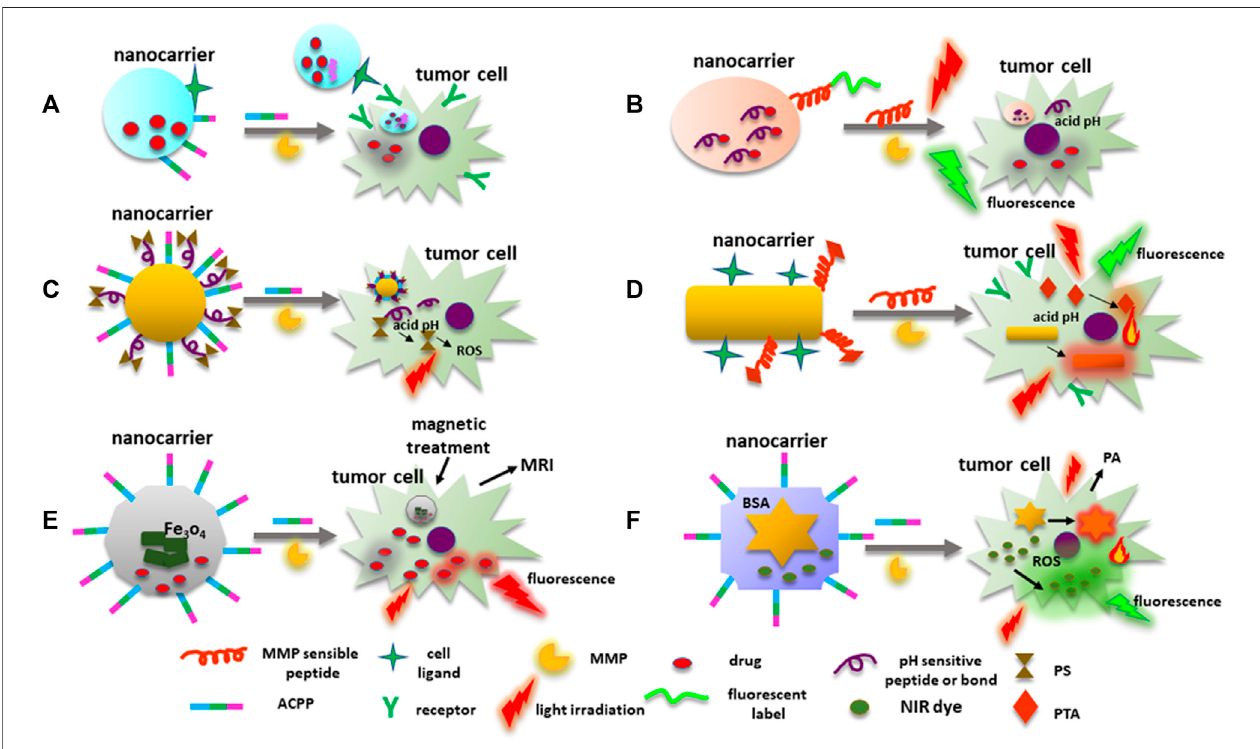
FIGURE6| MMPs ’ cleavablepeptidesinnanocarriers ’ construction. (A) Anexampleofananosystemdesigned fordrugtransportwithligandstotarget neoplastic cells. ACPPs with an MMP sensible peptide, are directly conjugated to NM surface to facilitate nanocarrier cell uptake. (B) Fluorescence label linked to a nanocarrier surface through an MMPs ’ sensible peptide emits fl uorescence when active MMPs disrupt the peptide. Drugs transported by the nanocarrier can be linked to the NP throughanacidicpH-sensitiveboundorpeptidethatisdisruptedinthecell,releasingthecytotoxicdrug. (C) ACCP-MMPsensiblepeptideandPSsforPDTcanbe integrated to a nanosystem. PS is conjugated into the nanoprobe through an acidic pH-sensitive link or peptide. Once the PS is released into the cell, light irradiation induces ROS production damaging the tumor cell. (D) Nanocarriers can contain PTAs for PTT attached to the NPs by MMP cleavable peptides, NPs included in the probecanbehaveasPTAs.PTAscanalsoemit fl uorescenceunderlightirradiation. (E) Nanoplatformsusedforchemotherapy,andmagnetictreatmentcanalsobeused for fl uorescentandMRimages.MMPsensitivepeptidesareemployedtodeliverthesystemtotheneoplasticcells.DOXunderlightirradiationemitsred fl uorescence. (F) Nanocarriers can be used simultaneously for PTT, PDT, and monitoring tumor cells by PA and fl uorescent images. AuNPs behave as fl uorescent quenchers, PTAs, and cell monitoring by PA images. MMP sensible peptides linked to BSA drive the nanoplatform to MMPs ’ overexpressing cells. Abbreviations: ACPPs, activable cell- penetrating peptides; DOX , doxorubicin; MMP, matrix metalloproteinase; NM, nanomaterial; NPs, nanoparticles; PA, photoacoustic; PDT, photodynamic therapy; PTAs, photothermal transduction agents; PSs, photosensitizers; PTT, photothermal